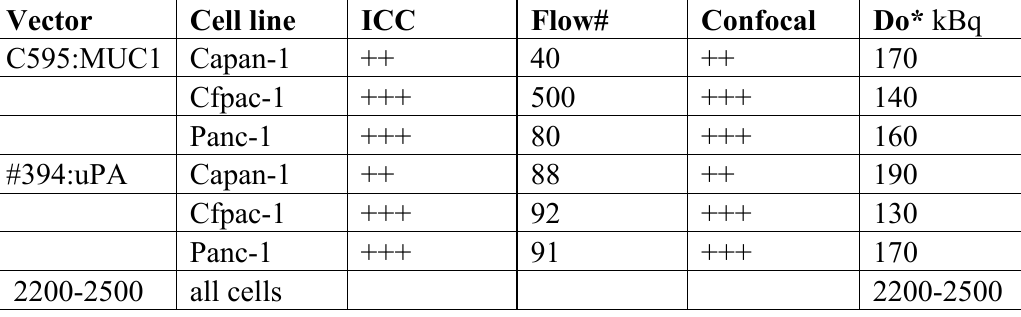
Table 2. Comparison of cell line properties.